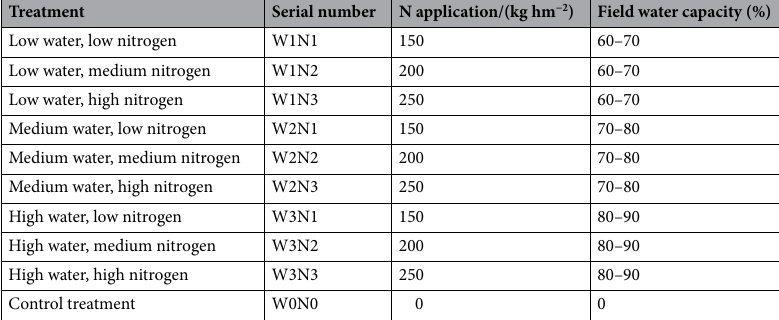
Table 1. Experimental treatment of water–nitrogen coupling in Isatis indigotica